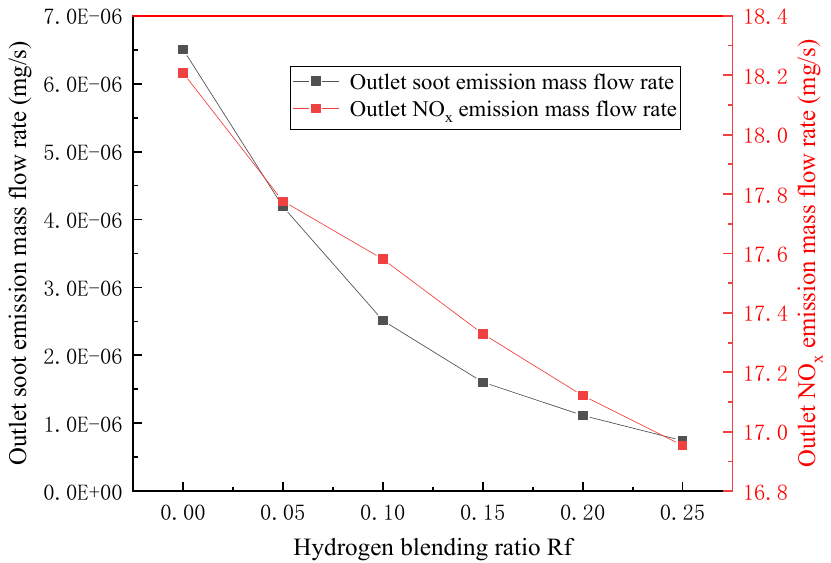
Figure 18. Changes of total emissions of NO x and soot.